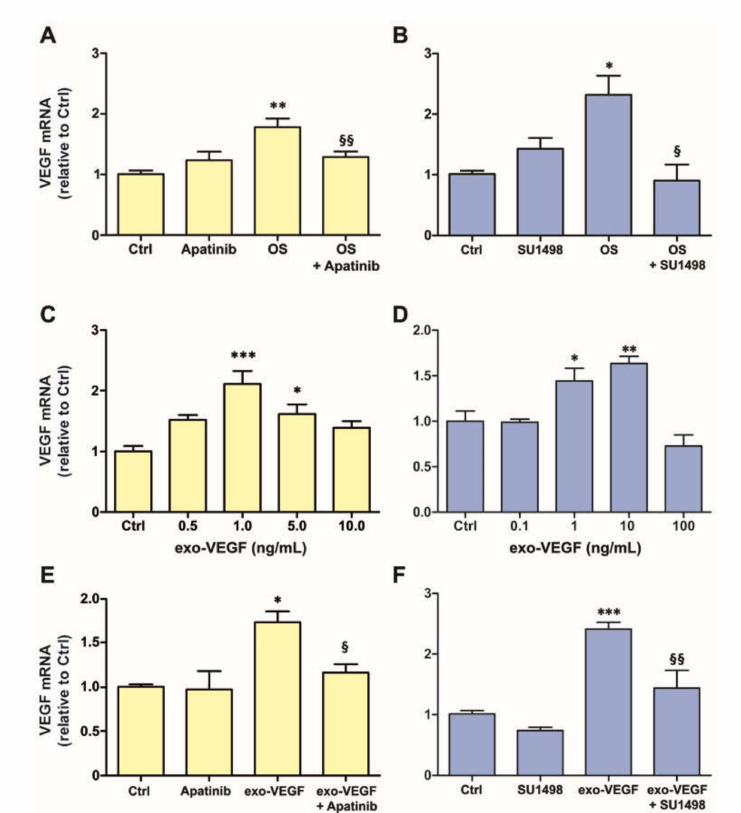
Figure 1. ( A ) and ( B ) represent vascular endothelial growth factor ( VEGF ) mRNA expression in MIO-M1 cells and in retinal explants, respectively, exposed to oxidative stress (OS; 400 µ M H 2 O 2 for MIO-M1 cells and 100 µ M H 2 O 2 for retinal explants) for 24 h and e ff ect of a vascular endothelial growth factor receptor 2 (VEGFR2) blocker (0.1 µ M Apatinib for MIO-M1 cells and 25 µ M SU1498 for retinal explants). * p < 0.05 and ** p < 0.01 relative to controls (Ctrl); § p < 0.05 and §§ p < 0.01 relative to OS. ( C ) and ( D ) represent VEGF mRNA expression in MIO-M1 cells and in retinal explants, respectively, exposed to di ff erent concentrations of exogenous VEGF (exo-VEGF) for 24 h. * p < 0.05 ** p < 0.01 and *** p < 0.001 relative to Ctrl. ( E ) and ( F ) represent VEGF mRNA expression in MIO-M1 cells and in retinal explants, respectively, in response to the most e ff ective concentration of exo-VEGF (1 ng / mL in MIO-M1 cells and 10 ng / mL in retinal explants) and the e ff ect of a VEGFR2 blocker (Apatinib for MIO-M1 cells and SU1498 for retinal explants). * p < 0.05 and *** p < 0.001 relative to Ctrl; § p < 0.05 and §§ p < 0.01 relative to exo-VEGF. n = 3 in ( A – E ); n = 5 in ( F